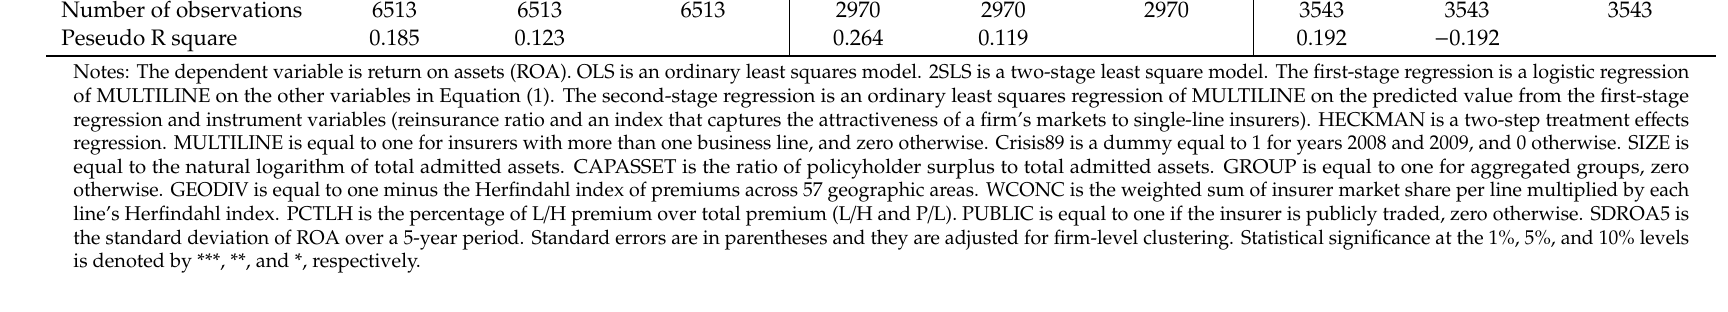
Table 5. Diversification E ff ect on Performance (ROA), Group vs.